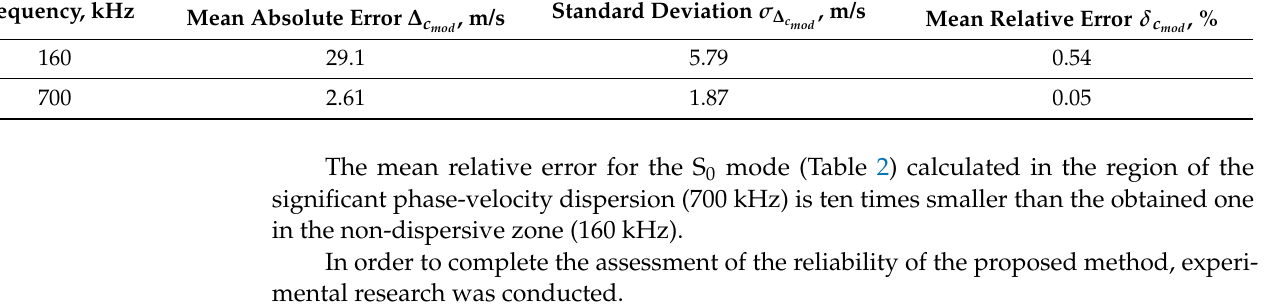
Table 2. The metrological characteristics of the phase-velocity ( v = 5402 m/s) dispersion curve for the S 0 mode.